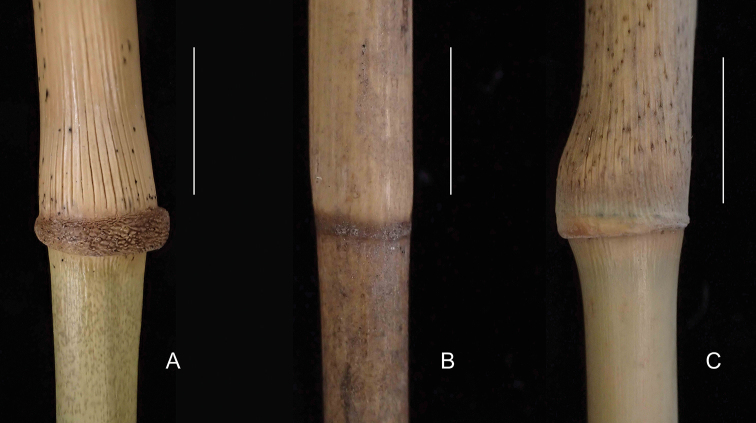
Comparison of culm leaf sheath bases AKhoonmengia
honbaensis, showing swollen culm leaf sheath base with a distinctive zone of transverse wrinkles (From N. H. Xia et al. BVN2017048) BHsuehochloa
calcarea, showing flat and smooth culm leaf sheath base (From Y. Y. Zhang zyy-030, IBSC) CAmpelocalamus
actinotrichus, showing slightly swollen and nearly smooth culm leaf sheath base (From N. H. Xia et al. HN-025, IBSC). Scale bars: 1 cm (A, C); 5 mm (B).